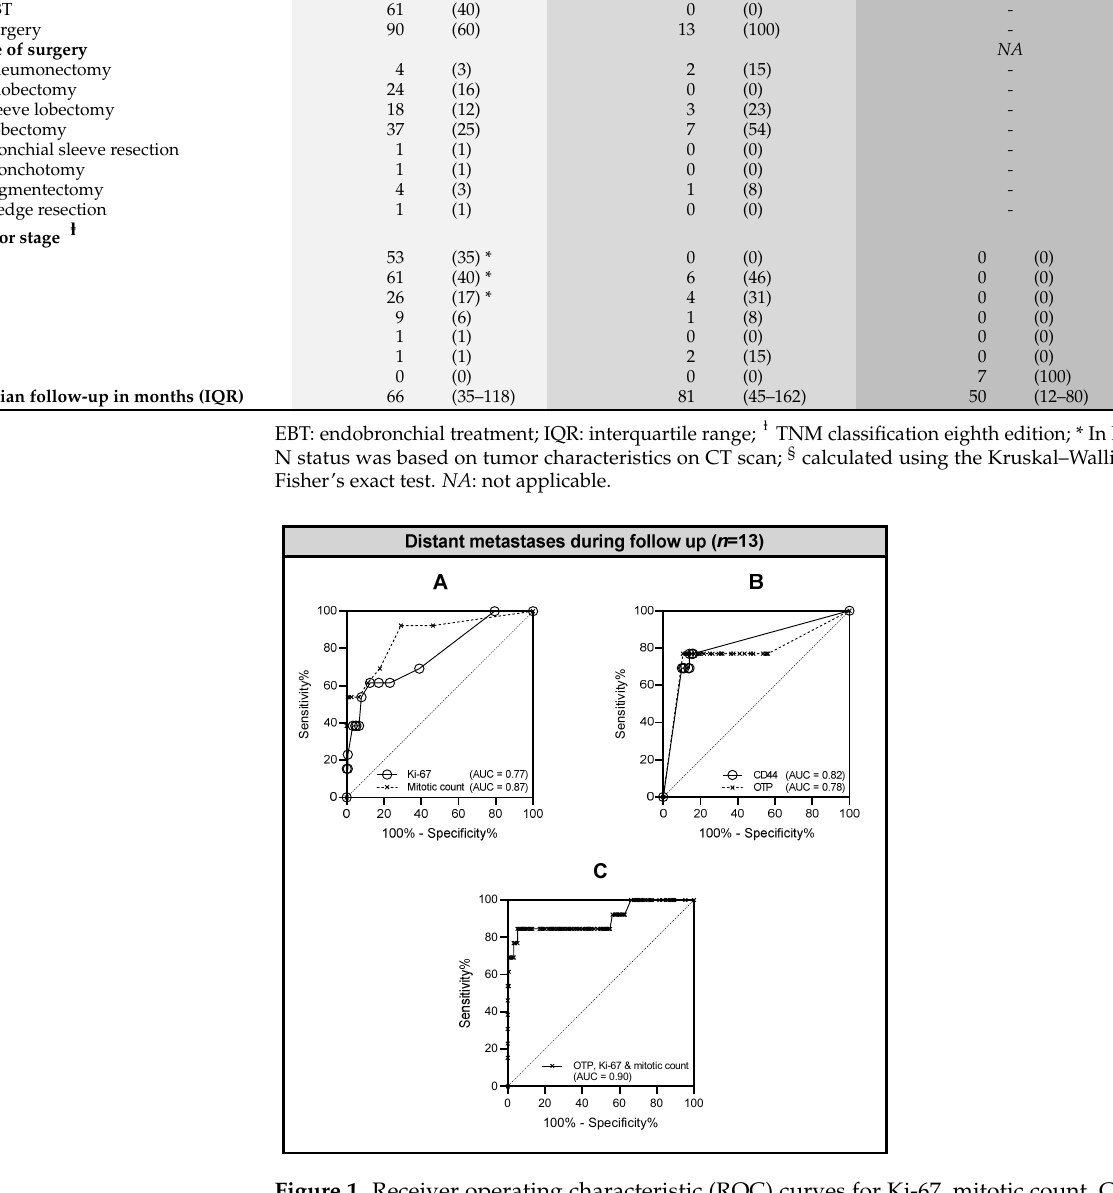
Figure 1. Receiver operating characteristic (ROC) curves for Ki-67, mitotic count, CD44, and OTP. Panels ( A – C ) present ROC curves of individual (( A ) Ki-67, p = 0.003, and mitotic count, p < 0.000; ( B ) CD44, p < 0.000, and OTP, p < 0.000)) and combined markers (( C ) OTP, Ki-67, and mitotic count, p < 0.000) for distinguishing occurrence of distant metastases ( n = 13) from no occurrence of distant metastatic disease during